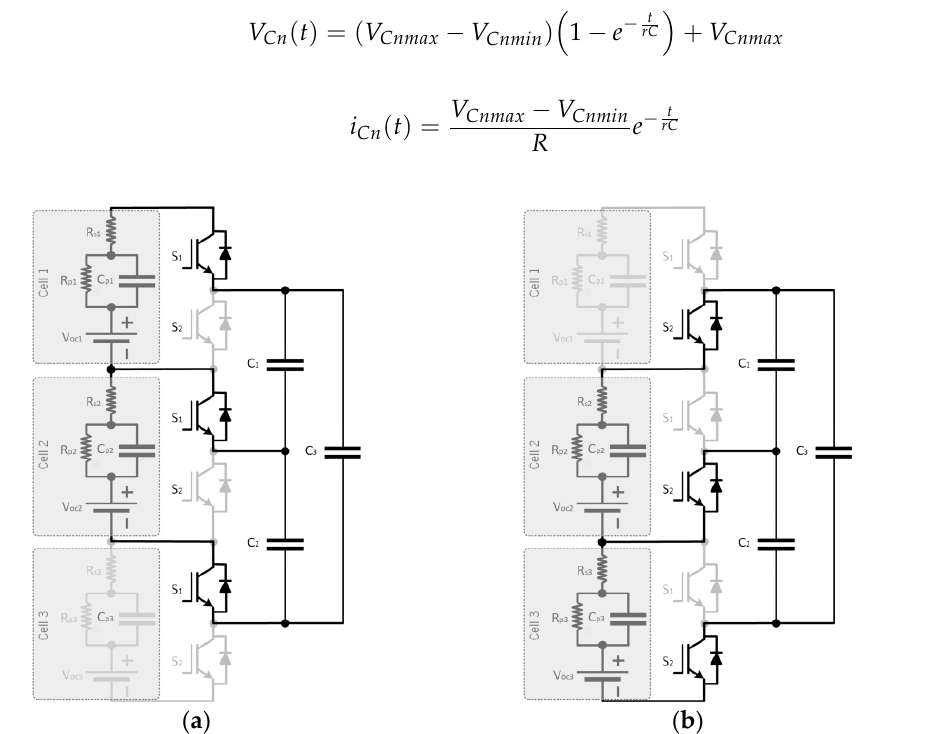
Figure 6. Operating modes of the DTSC converter: ( a ) first stage, T 1 ; ( b ) second stage, T 2 .